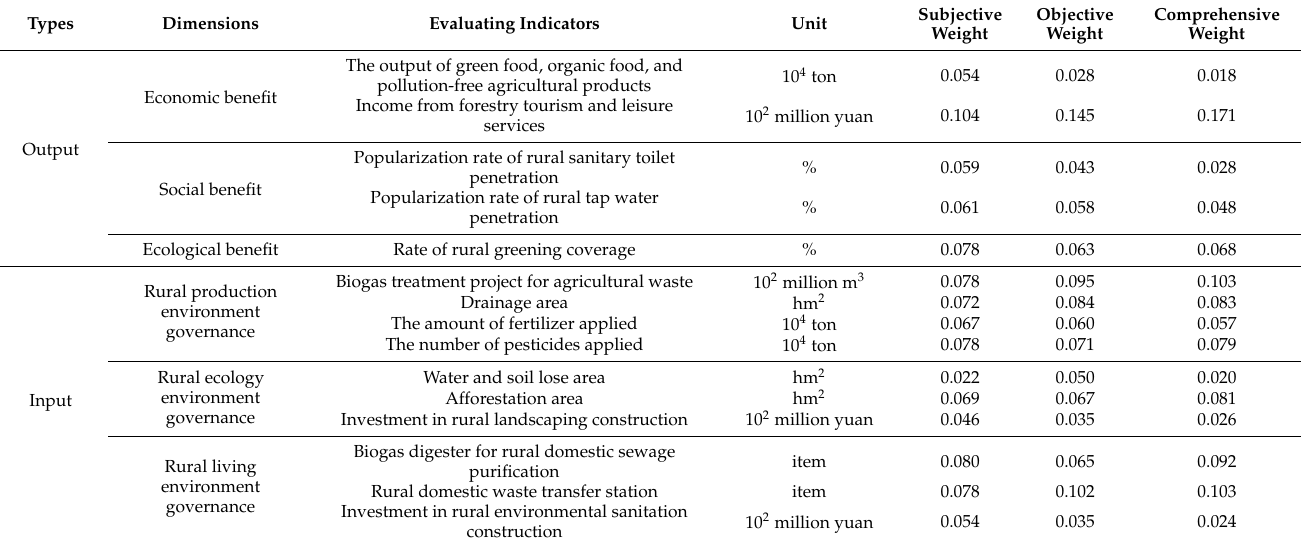
Table 1. The rural ecological environment governance efficiency index